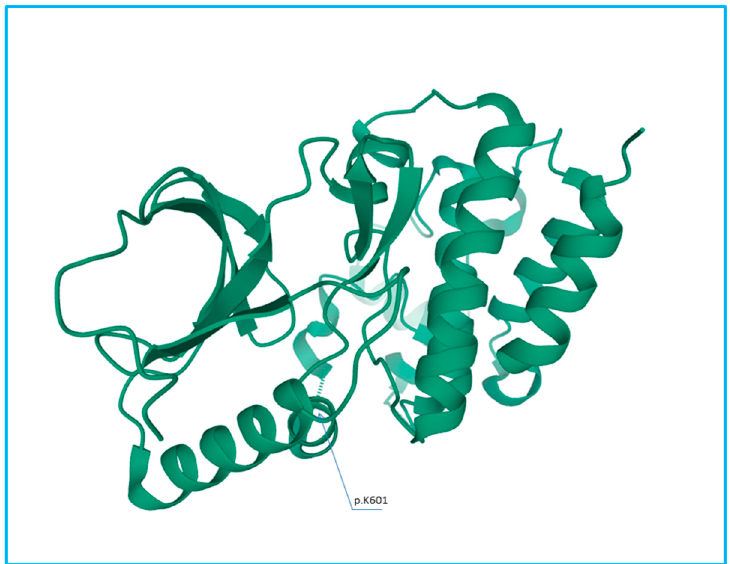
Figure 3. 3D representation of the BRAF protein. The blue arrow highlights the codon 601. This figure was created using Mol* PDB ID Mol* and Research Collaboratory for Structural Bioinformatics (RCSB) Protein Data Bank (PDB).